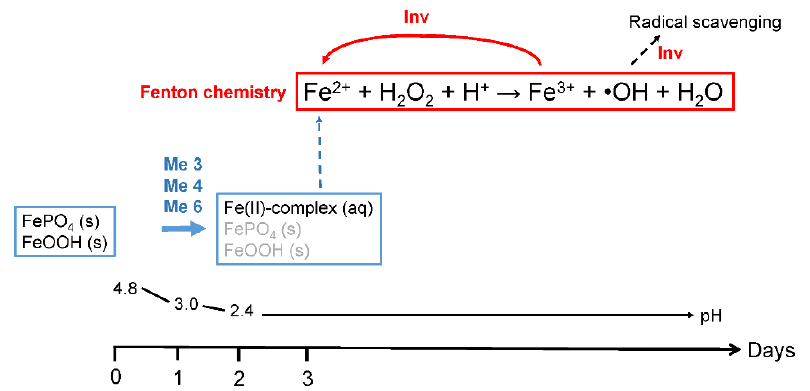
Figure 6. A schematic representation of the speciation of extracellular iron and production of iron(III)-reducing metabolites by P. involutus when grown for 7 days on BSA-containing medium. Initially, the iron is present as solid iron(III) phosphate and oxide complexes. These complexes are rapidly dissolved by not yet fully characterized iron(III)-reducing metabolites (denoted Me3, Me4 and Me6, corresponding to peaks 3, 4 and 6 in Table 3).The reduction results in the formation of soluble iron(II) complexes that are the main iron species present in the medium from day 2. Fenton chemistry is triggered on day 3, at a time when involutin (Inv) is detected in the medium. We propose that Inv is involved in reducing and recycling the iron(III) formed in the Fenton reaction. Inv can also be involved in scavenging the • OH radicals formed in the Fenton reaction and thereby protect the fungal hyphae from high levels of damaging radicals. See text for further details.